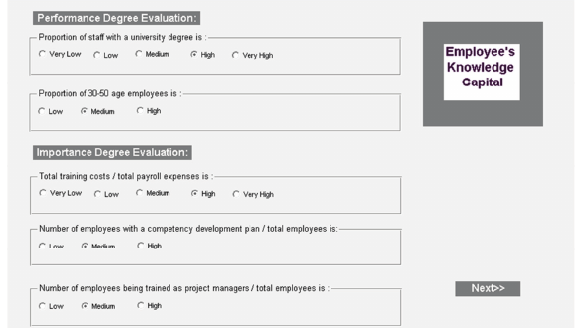
Figure 9: A view of the proposed model